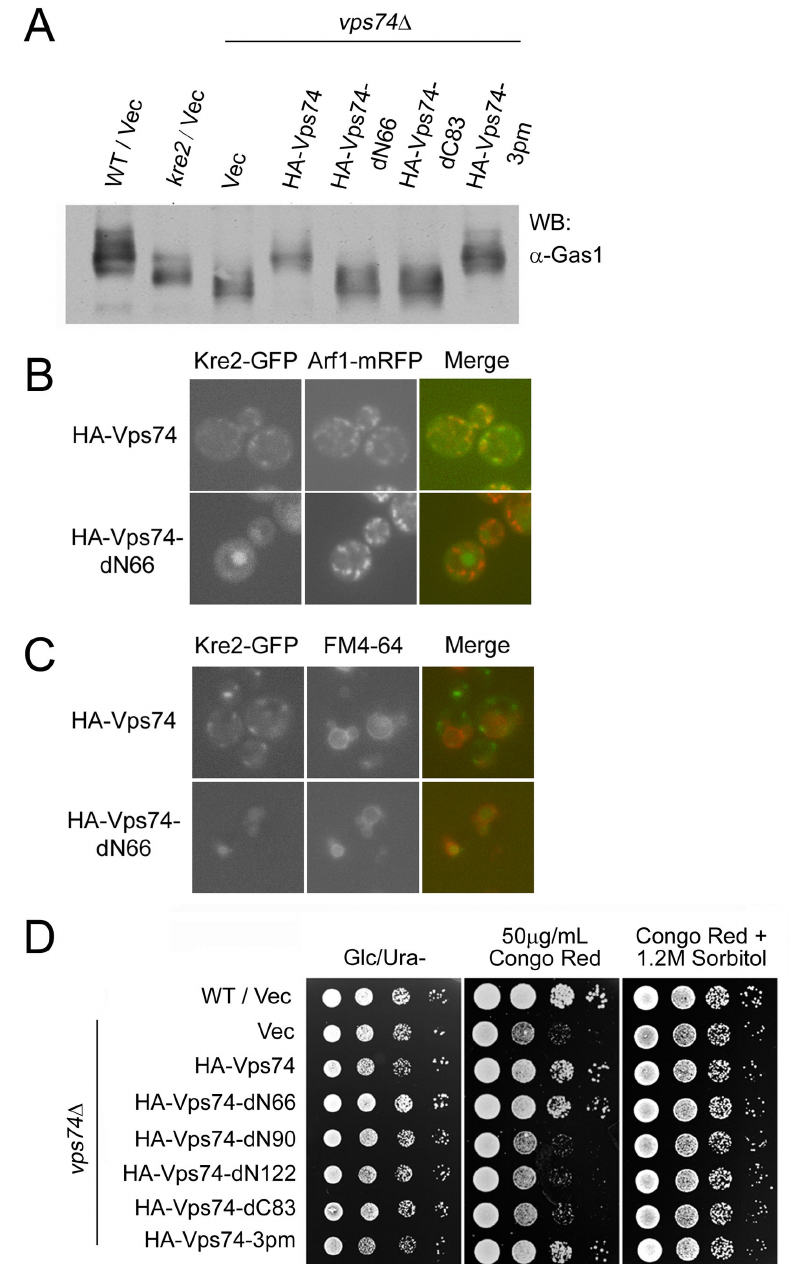
Figure 3. The effects of Vps74p on cell wall integrity are not due to the mislocalization of glycosyltransferases. (A) BY4741 wild-type, kre2 Δ, and vps74 Δ mutants were transformed with the empty vector pVT101U (Vec). BY4741 vps74 Δ was transformed with HA-tagged Vps74, Vps74p-dN66, Vps74p-dC83, and Vps74p-3pm. Lysates prepared from these cells were subjected to Western blot analyses using an anti-Gas1p antibody. (B) and (C) The localization of Kre2p-GFP in vps74 Δ mutant cells. HA-VPS74 and HA-VPS74-dN66, under the control of the ADH promoter in a 2μ plasmid, was transformed into vps74 Δ mutant strains expressing Kre2p-GFP from its native locus. Transformants were grown in selection medium and the GFP signals were observed. Expression of Arf1p-mRFP was used as a Golgi marker. FM4-64 tracer dye was used for vacuole localization. (D) BY4741 was transformed with the empty vector pVT101U (Vec), and BY4741 vps74 Δ yeast were transformed with pVT101U (Vec) and HA-tagged Vps74p, Vps74p-dN66, Vps74p-dN90, Vps74p-dN122, Vps74p-dC83, and Vps74p-3pm. These cells were cultured to mid-log phase. Subsequently, 10-fold serial dilutions were spotted onto Ura minus plates containing 2% glucose (left panel), YPD plates containing 50 µg/ml Congo red (middle panel), or YPD plates containing 50 µg/ml Congo red and 1.2 M sorbitol (right panel). doi: 10.1371/journal.pone.0074715.g003 PLOS ONE |